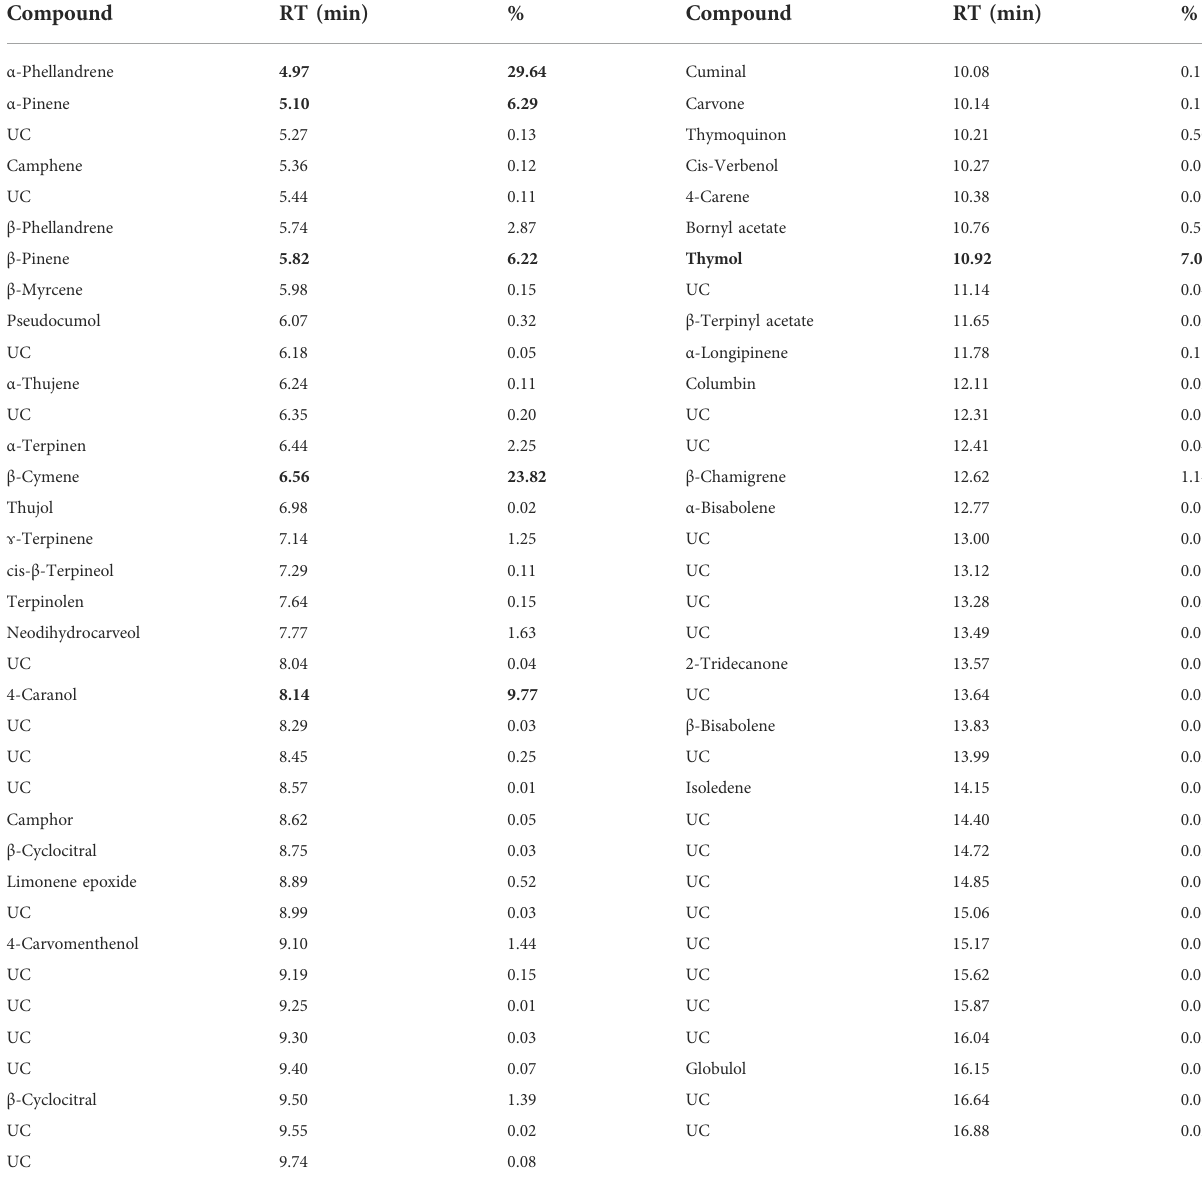
TABLE 1 The identi fi ed chemical components in NS essential oil by GC-MS. (Dalli, 2021).